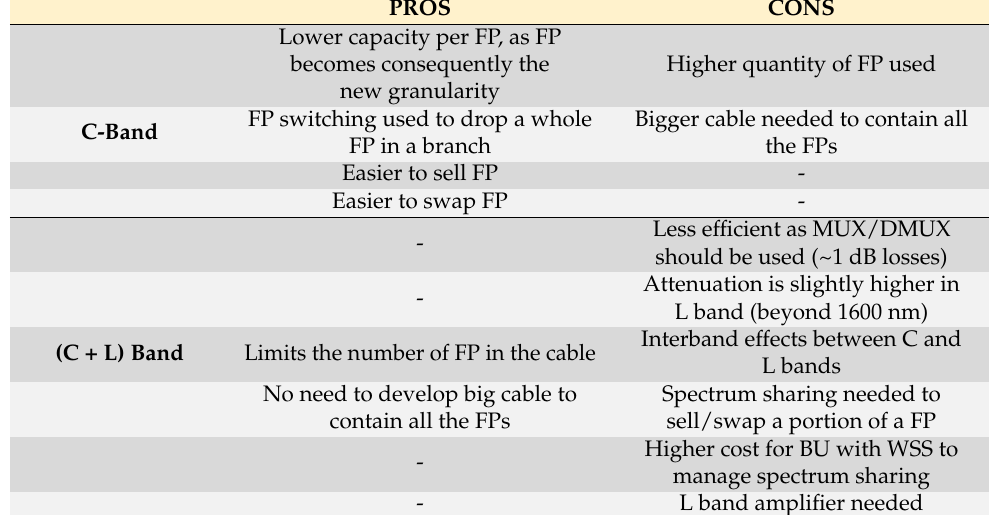
Table 2. Compare SDM with other non-SDM solutions [8].